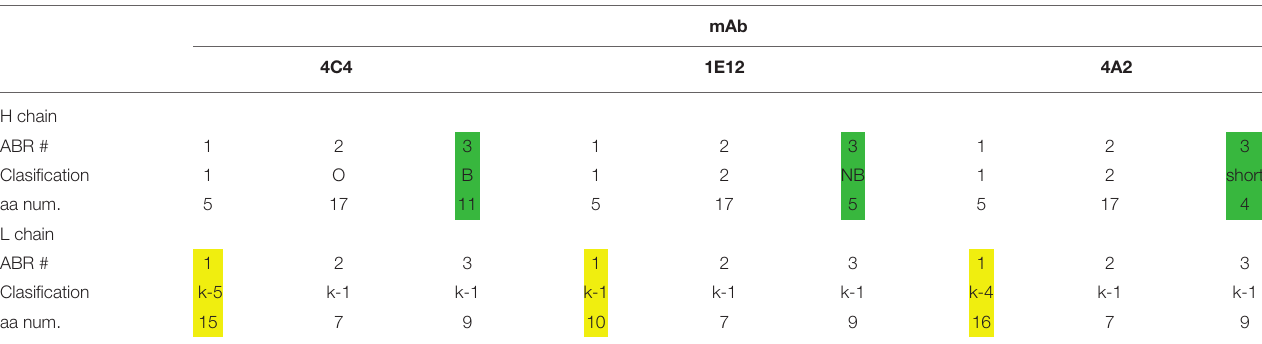
The table displays features for novel, 1E12 and 4A2, and reference 4C4 mAbs. Classification was according to the Kabat–Chothia canonical structures, where “O” (other) refers to H-ABR not belonging to any canonical structure class. For H3 ABRs, the only two canonical structure classes used were B (bulged) and N (non-bulged). For L chains, “k” stands for kappa. The green and yellow boxes correspond to the more relevant CDR in H and L chains,